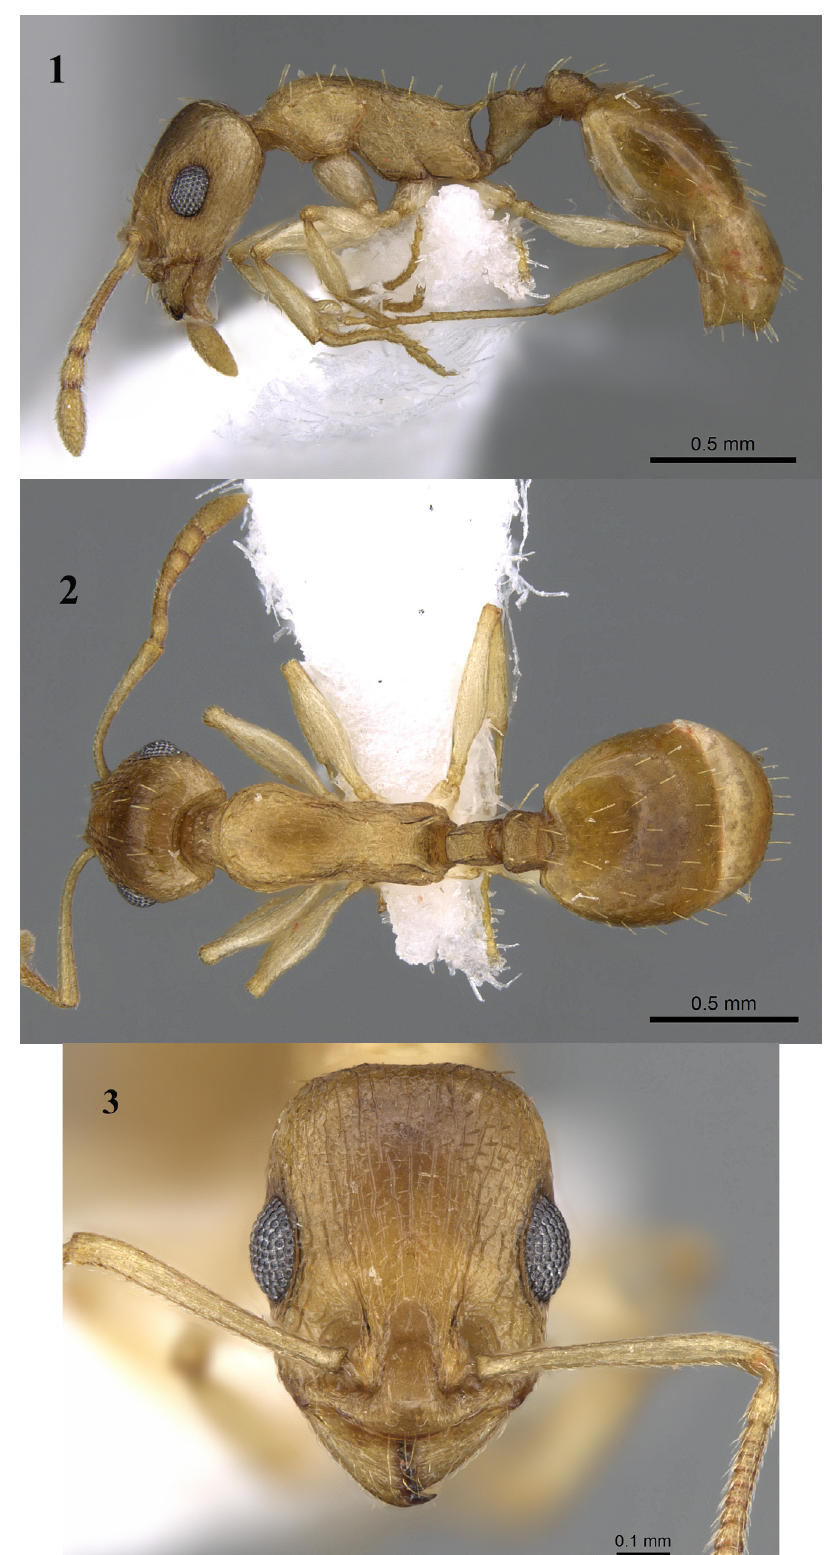
Figs 1–3 . Temnothorax arabicus Sharaf & Akbar sp. nov., holotype, worker (CASENT0746640) 1 . Body in profile. 2 . Body in dorsal view. 3 . Head in frontal